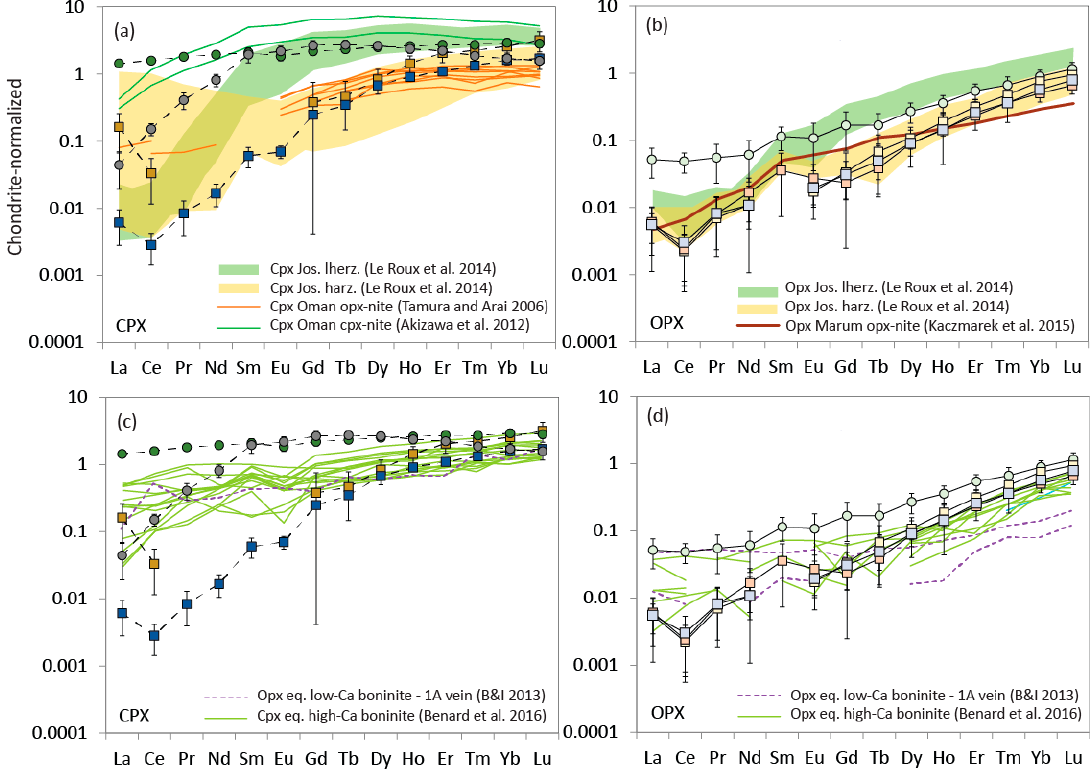
Figure 11. REE concentrations normalized to chondrite [42] in ( a , c ) CPX and ( b , d ) OPX from this study (same symbols as Figure 6), compared with pyroxene compositions in Oman pyroxenites [57], Marum orthopyroxenite [58], Josephine peridotites [40], Kamchatka amphibole-bearing websterites attributed to percolation of high-Ca boninites [12], and Kamchatka amphibole-bearing pyroxenite (type 1A; rapidly crystallized) attributed to percolation of low-Ca boninites [16]. Error bars represent 2SE for each